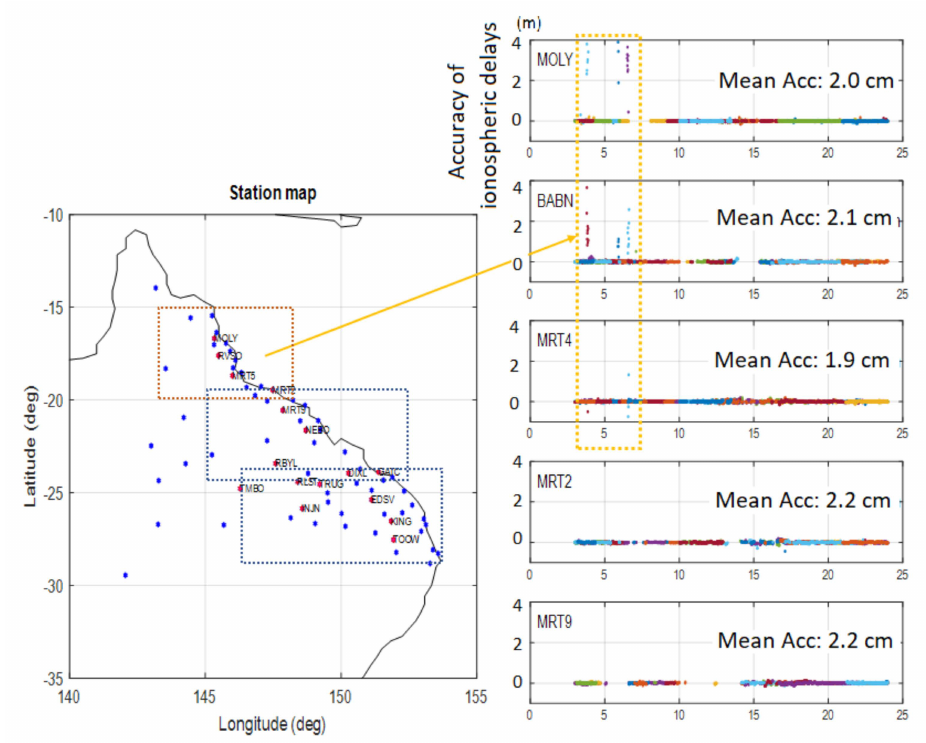
Figure 9. Plots showing the differences between the interpolated and measured ionospheric correc- tions as a function of time at some testing stations on 6 May 2021. The dash boxed in the station map show three testing areas. The red stations with names on the station map are the testing stations. The colours in the right boxes represent for different satellite observations. The dash-orange rectangle indicates some high variation in ionospheric